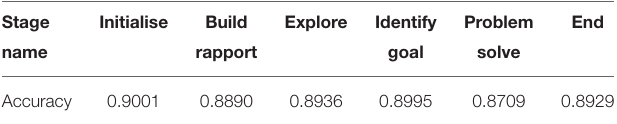
TABLE 4 | Classification accuracy for each conversation stage with the optimal model (Model ID 3 in Table 3 ).